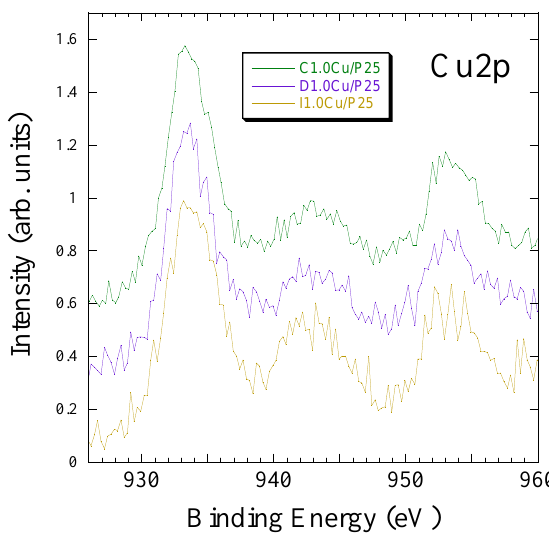
Figure 10. XPS Cu2p bands recorded on the three samples (starting from the bottom, samples I1.0Cu / P25, D1.0Cu / P25 and C1.0Cu / P25). Binding energy scale was corrected by the surface charging.